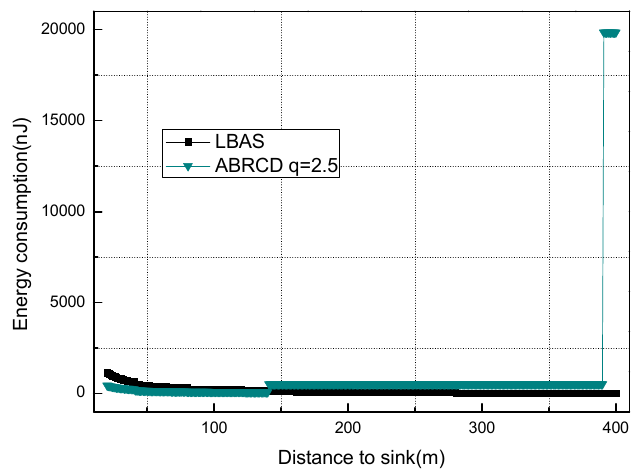
Figure 21. Energy consumption of nodes 20~400 m away from sink with q = 2.0.